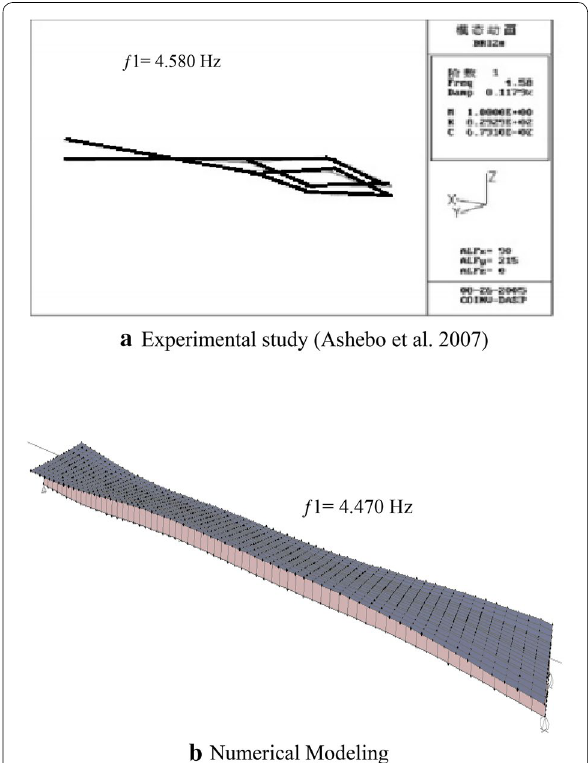
Fig. 4 First mode shapes from the experiment and numerical